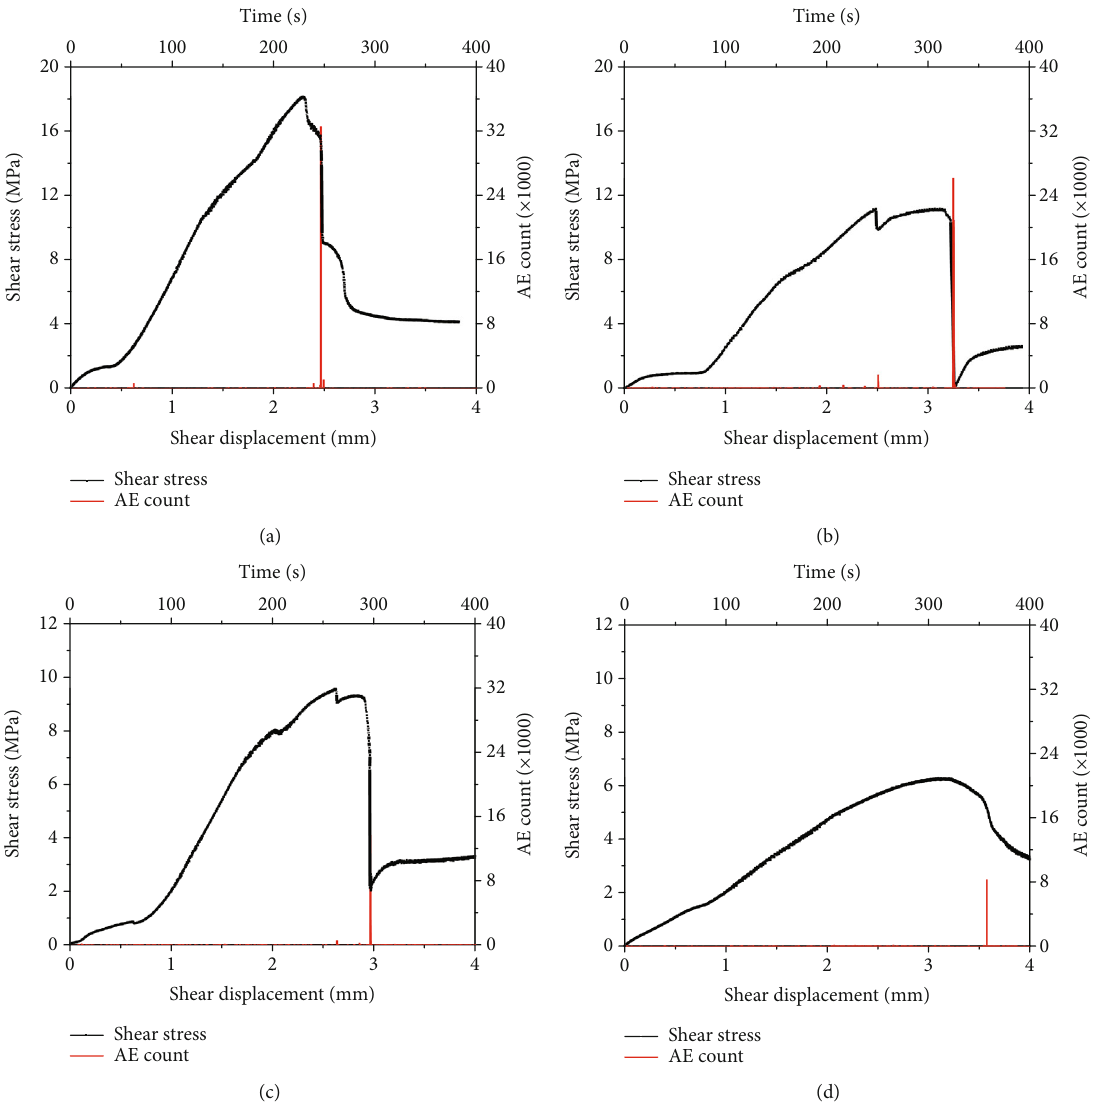
Figure 8: The cumulative AE events and shear stress with shear displacement of specimens with bilateral crack of di ff erent lengths: (a) 0 cm; (b) 2 cm; (c) 4 cm; (d)